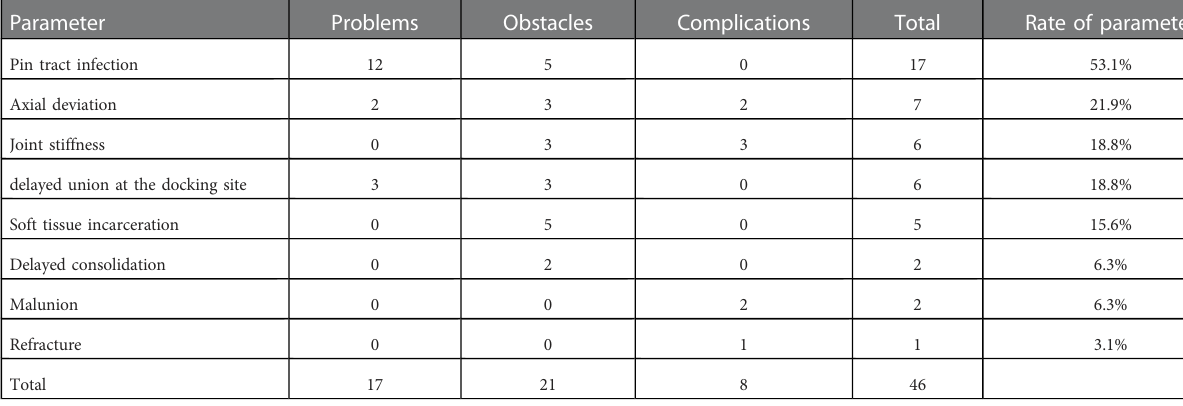
TABLE 2 Details of the complications.